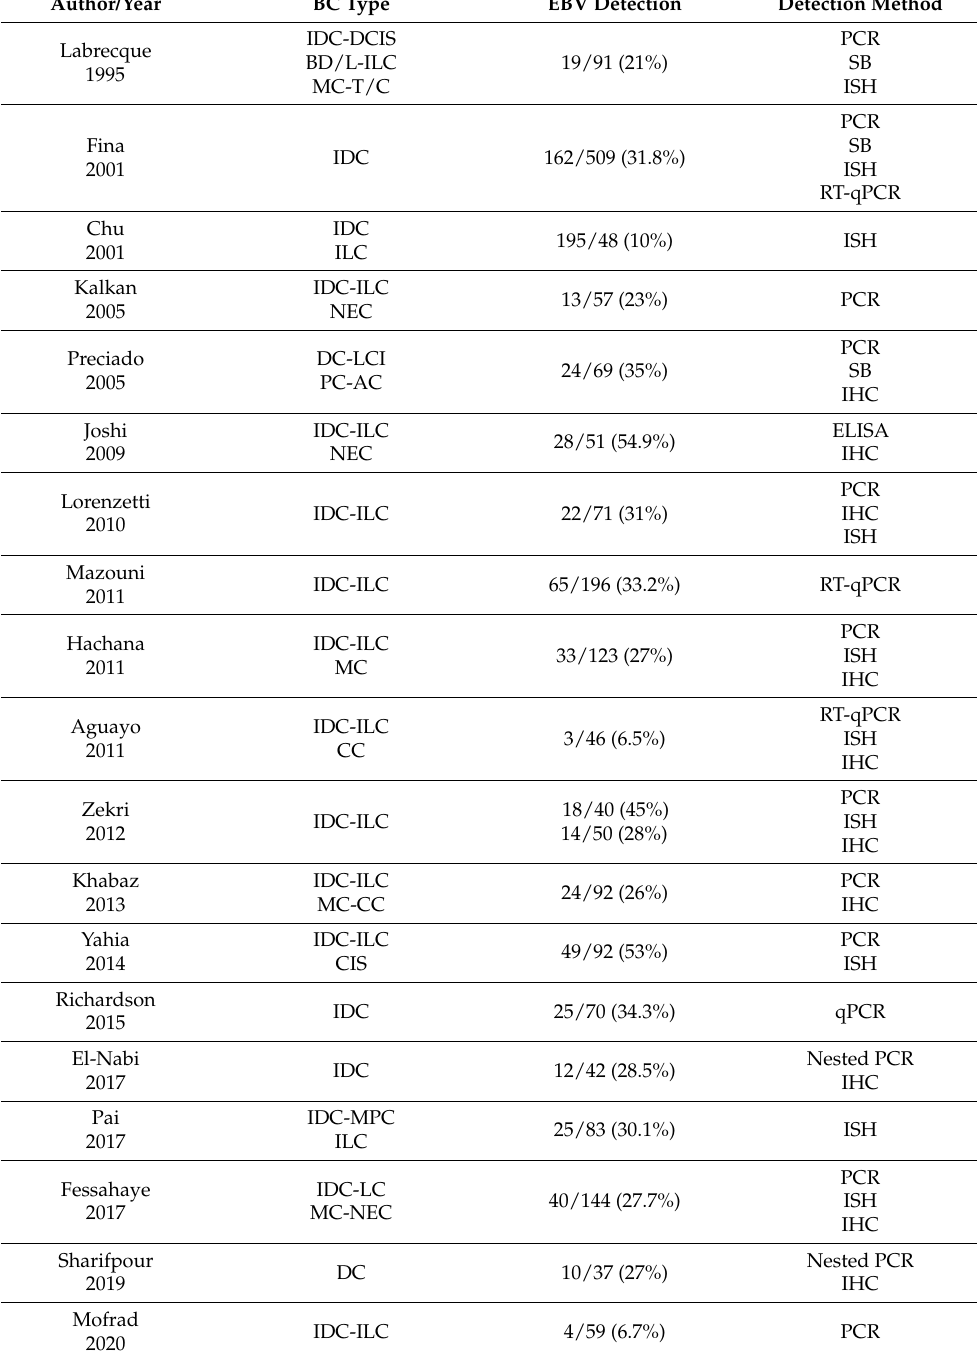
Table 1. Epstein–Barr virus presence in breast cancer